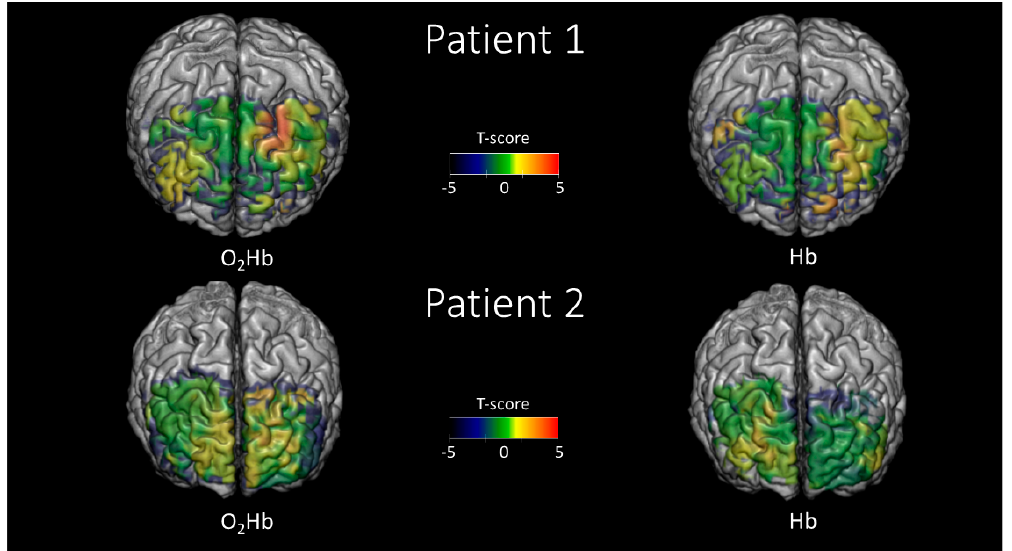
Figure 7. Statistical parametric maps (t-scores) evaluated employing the functional near-infrared spectroscopy-diffuse optical tomography (fNIRS-DOT) analysis and comparing the variability of the signal between task and rest for the Symbol Search (SS) test. The maps are reported in regions where the spatial sensitivity of the optical array was sufficient (up to an attenuation of the average optical sensitivity of 1000 times).